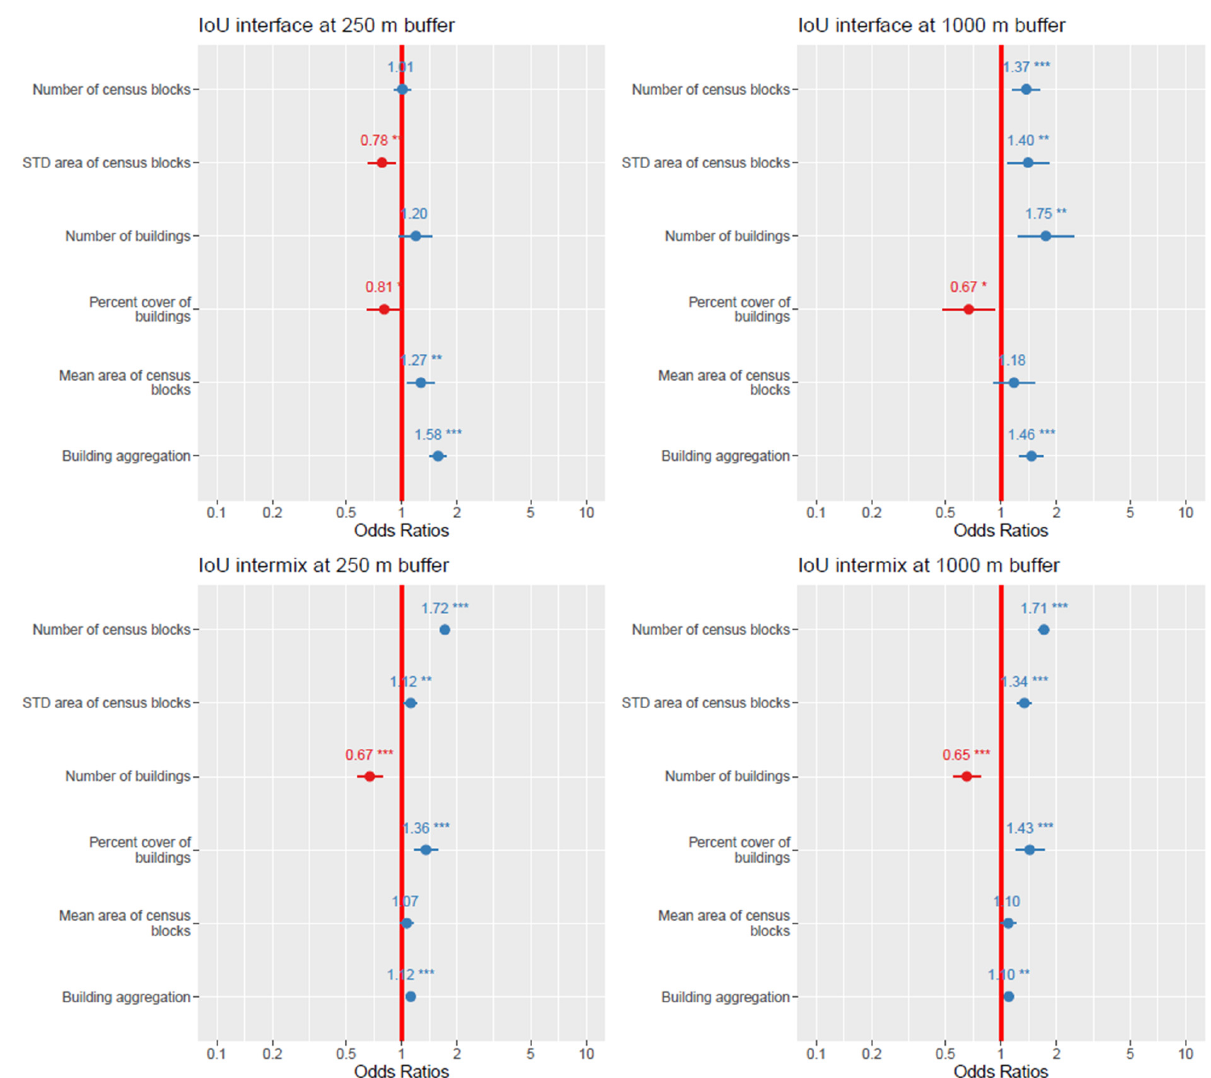
Figure 7. Effect sizes (as odds ratios) of the GLMs for the correspondence (as IoU) between the spatial patterns of zonal-based vs. point-based WUI maps. The top row depicts interface WUI, and the bottom row depicts intermix WUI. The left panels depict results of models of point-based WUI (at 250 m buffer distance), whereas the right panels are based on point-based WUI at 1000 m buffer distance. Coefficients are standardized, and the thick red line highlights an odds ratio of one. Significance levels: *** ( p < 0.001), ** ( p < 0.01), * ( p < 0.05). Model terms are explained in Section 2.4.